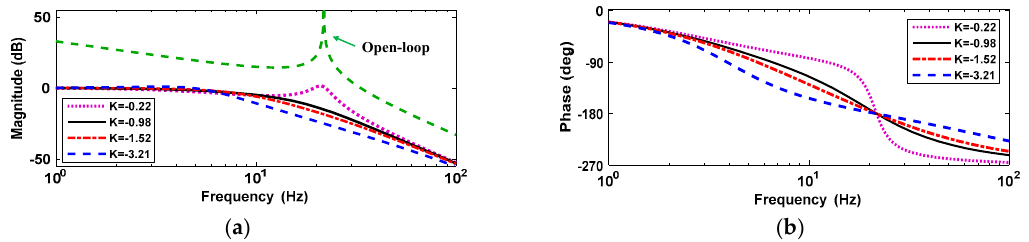
Figure 10. Bode plot of link-side controller from amplitude–frequency characteristic; ( b ) phase–frequency characteristic.